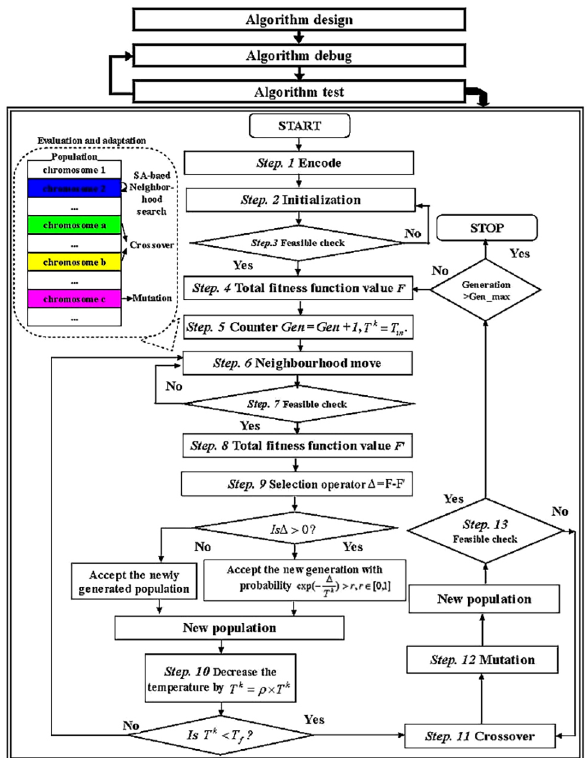
Fig. 4. The SA-based MOGA algorithm